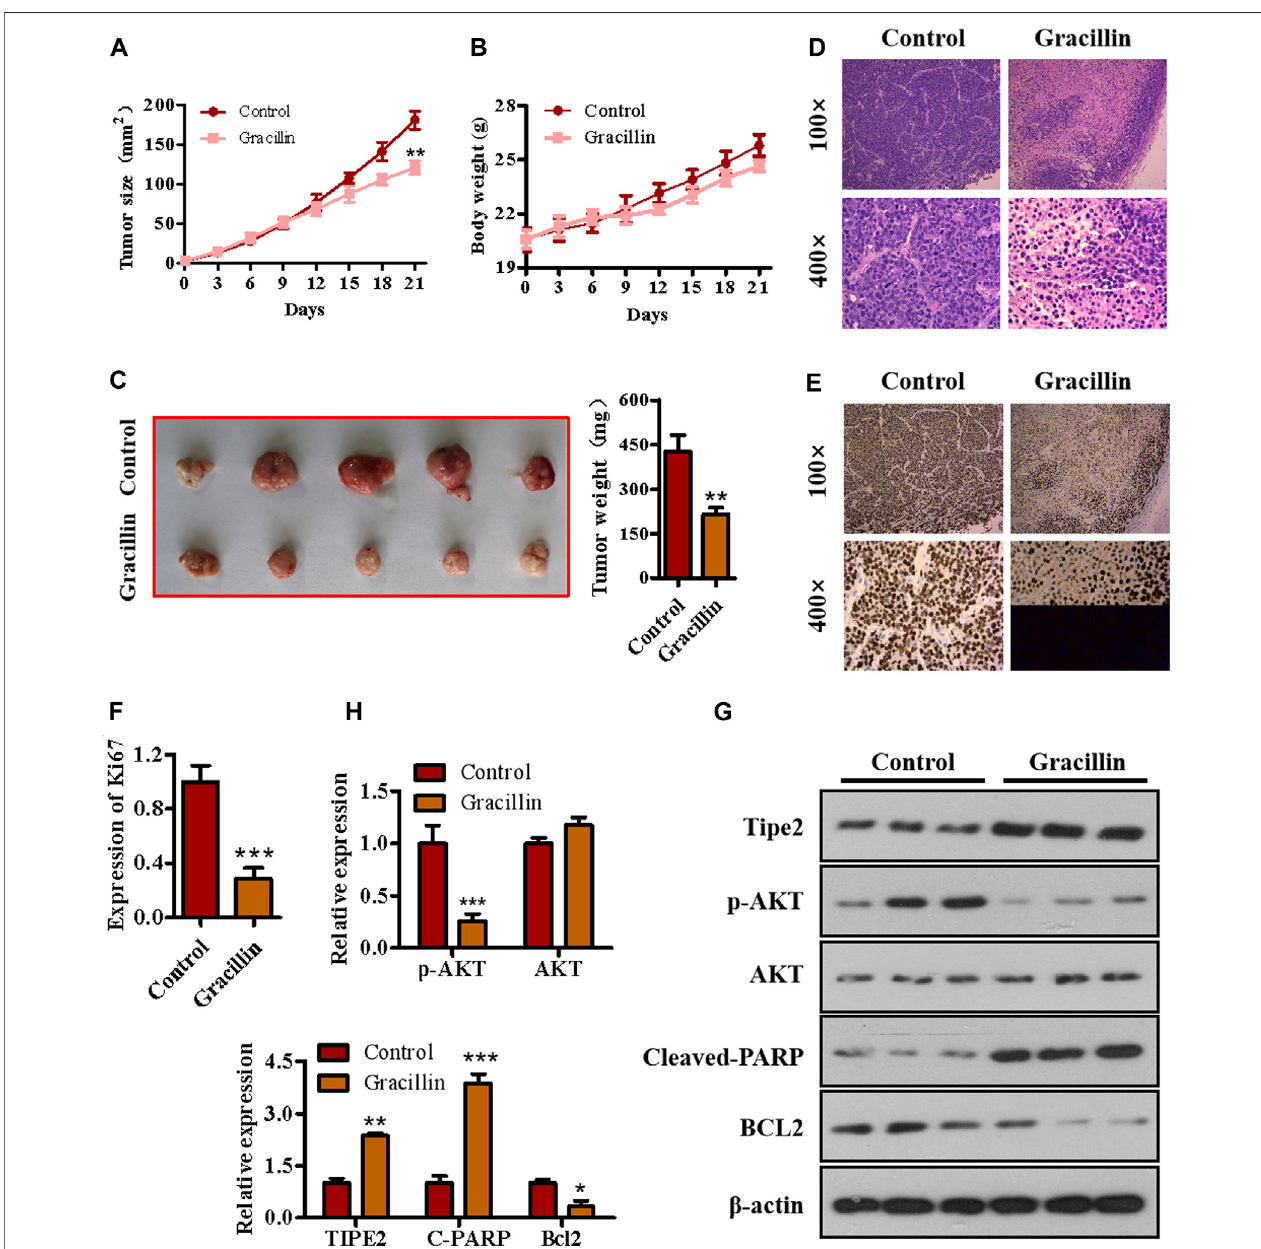
FIGURE 8 | The effect of gracillin on gastric tumor and TIPE2 expression in vivo . (A) The growth curve of tumors. (B) The curve of body weight. (C) The tumor images. (D) HEstainfortumorpathology. (E) IHCassayforki67expressionintumors. (F) Thequantitativeanalysisofki67expression. (G) Westernblotfortheexpression of TIPE2, p-AKT, AKT, cleaved PARP, and bcl2 in tumor tissue. (H) The quantitative analysis of protein expression as detected by western blot. 0.01 < p < 0.05 (*) representsasigni fi cantdifference, 0.001 < p < 0.001(**)representsaverysigni fi cantdifference and p < 0.001(***) representsanextremelysigni fi cantdifference to the normal